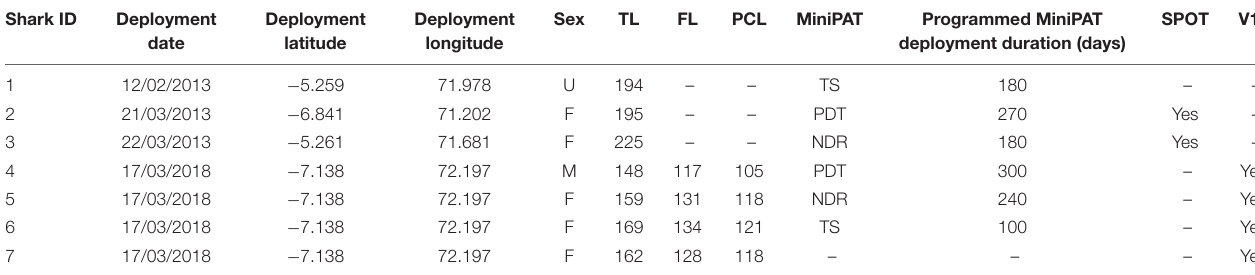
TABLE 1 | Tag deployments on silky sharks ( Carcharhinus falciformis) around the Chagos Archipelago between 2013 and 2018. Shark